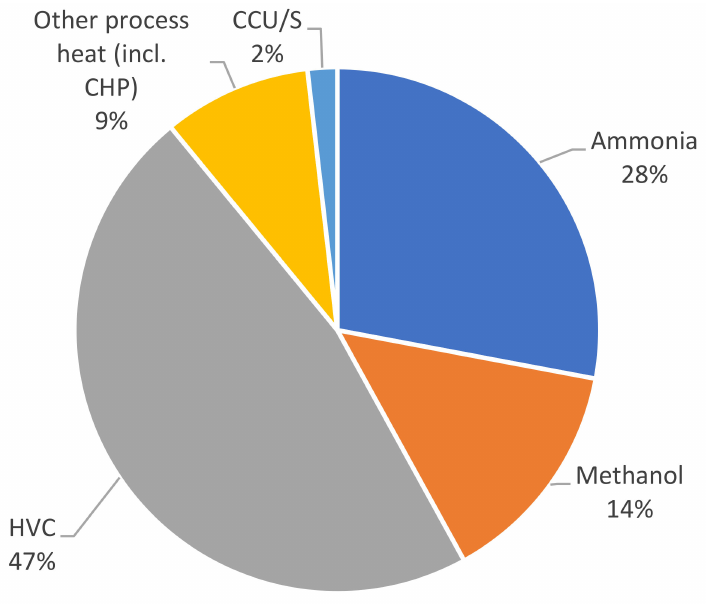
Figure 5. Estimated global use of biomass as fuel and feedstock in the 1.5 ◦ C case,